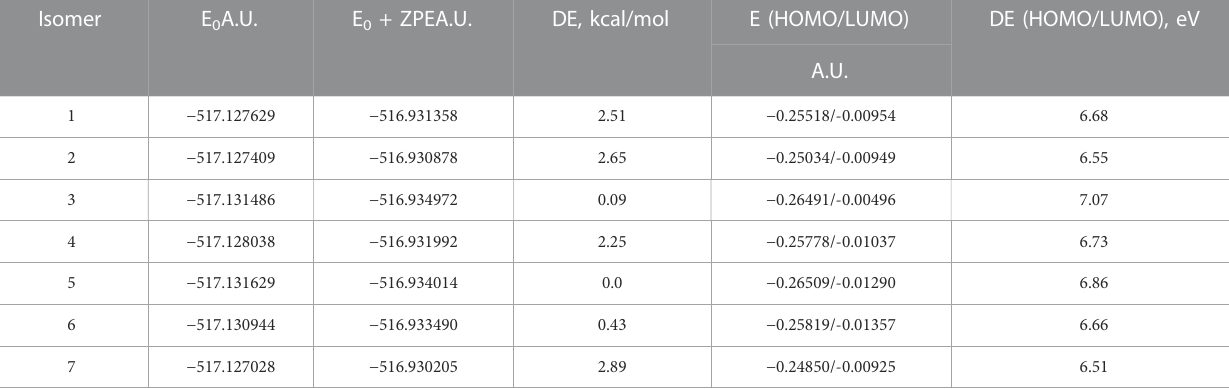
TABLE 8 Energetics of the seven optimized isomers of 4-hydroxyisoleucine calculated using the B3LYP/Def2TZVP method with the implicit effects of water. Isomer E A.U. E + 0 0